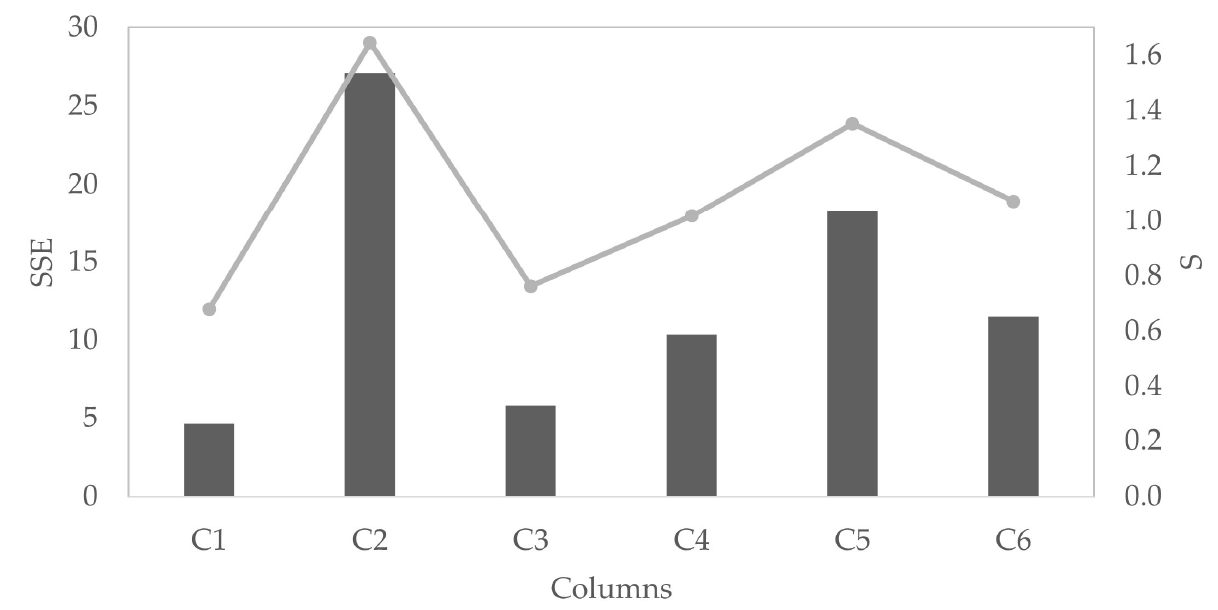
Figure 9. The goodness of fit for each column (test C) modeled, represented in sum of the squared residuals (SSE) (gray columns) and standard deviation of the distance between the data values and the fitted values (S indexes) (light gray line).